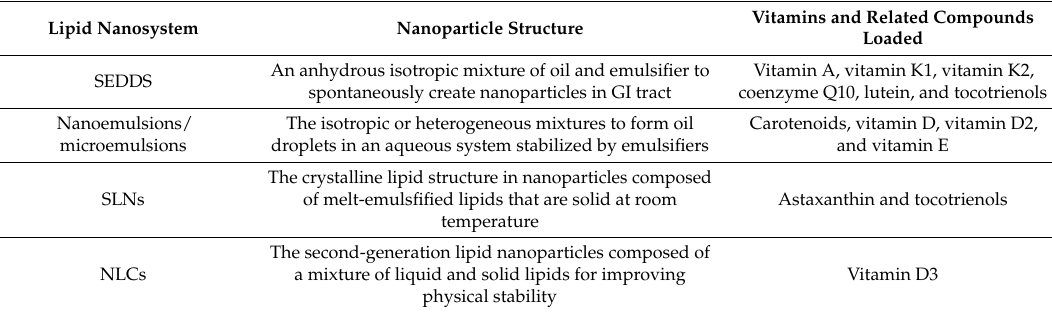
Table 4. The comparison of different lipid nanocarriers for enhancing oral vitamin